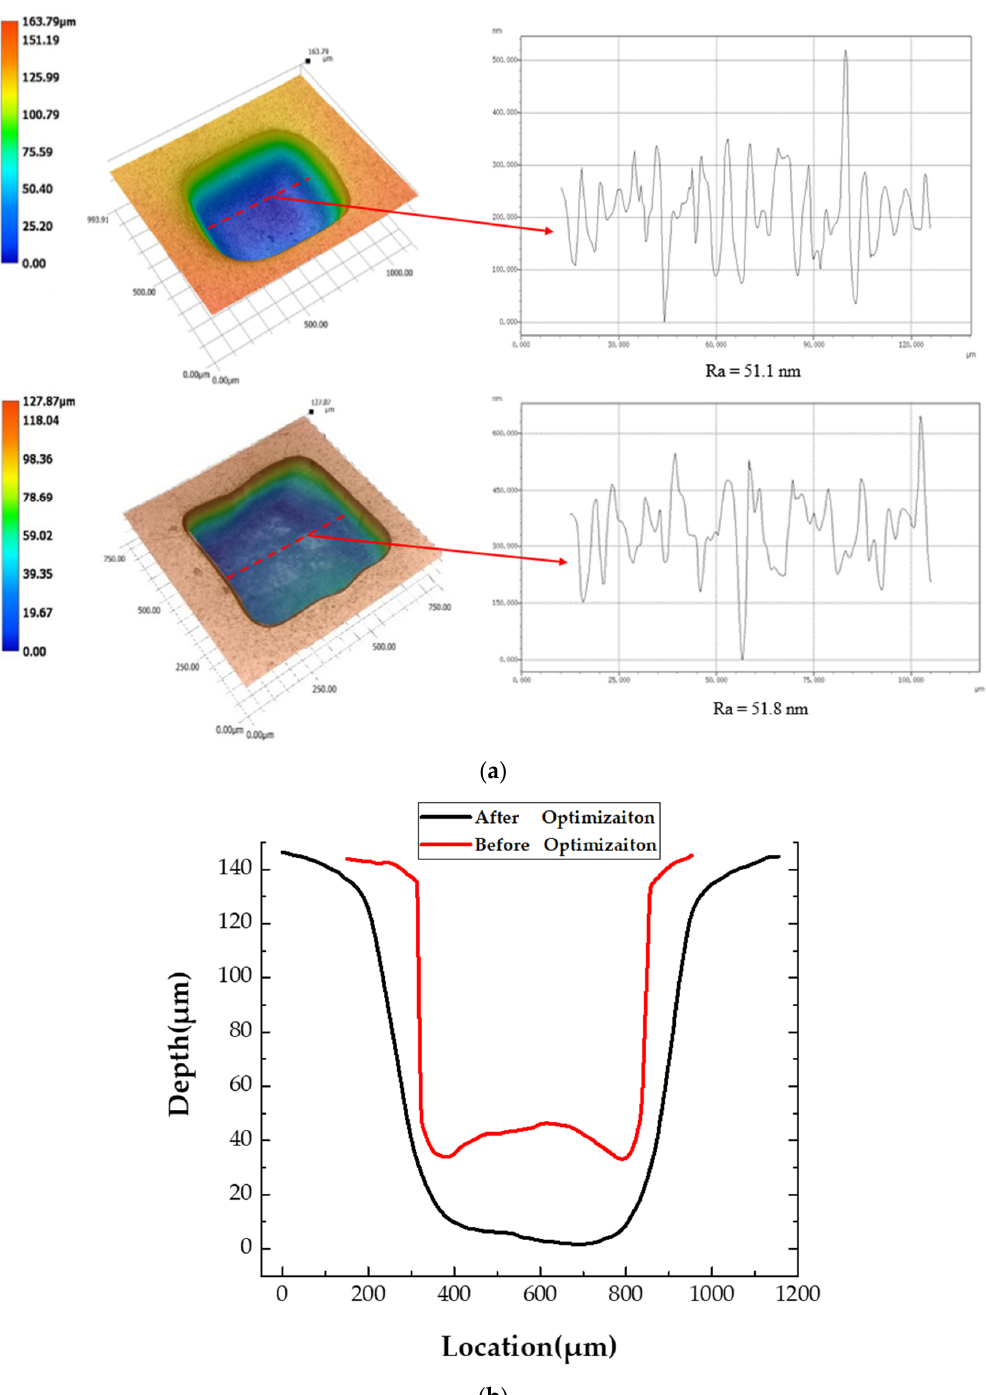
Figure 7. The R a and MRA before and after optimization. ( a ) The morphology of micro pit and its R a ; ( b ) The cross section of micro pit. ( b ) The cross section of micro